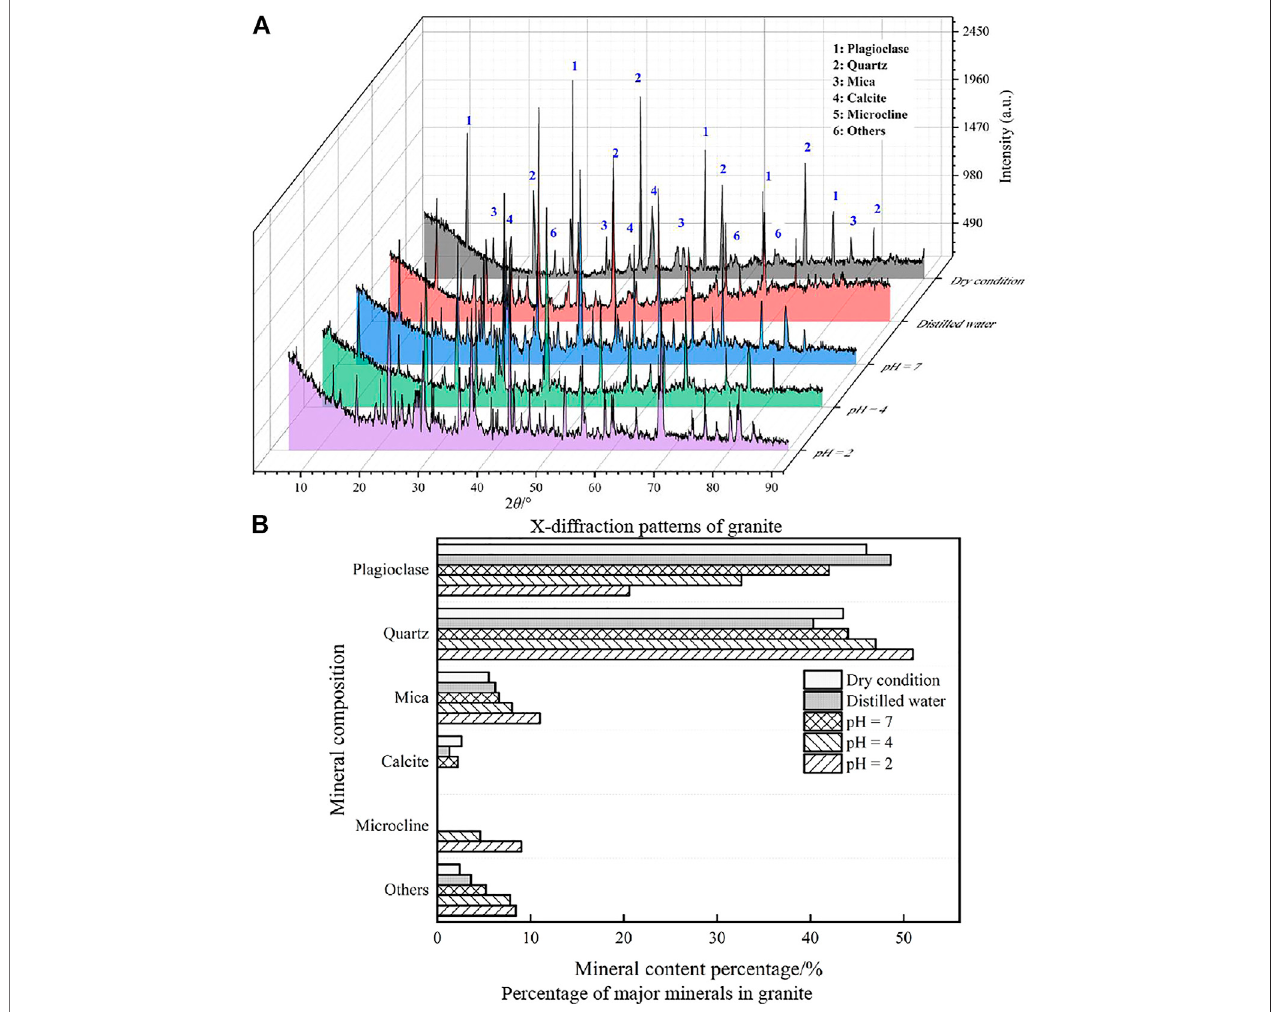
FIGURE 10 | X-ray diffraction results of granite mineral composition before and after different treatment. (A) X-diffraction patterns of granite. (B) Mineral content percentage/% percentage of major minerals in granite.